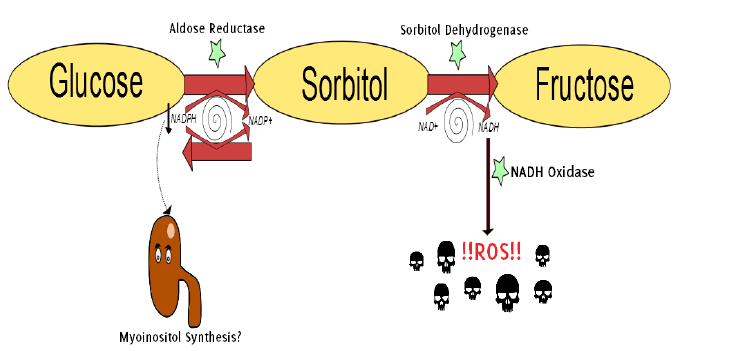
Figure 3. The Polyol Pathway in Hyperglycemia. 35